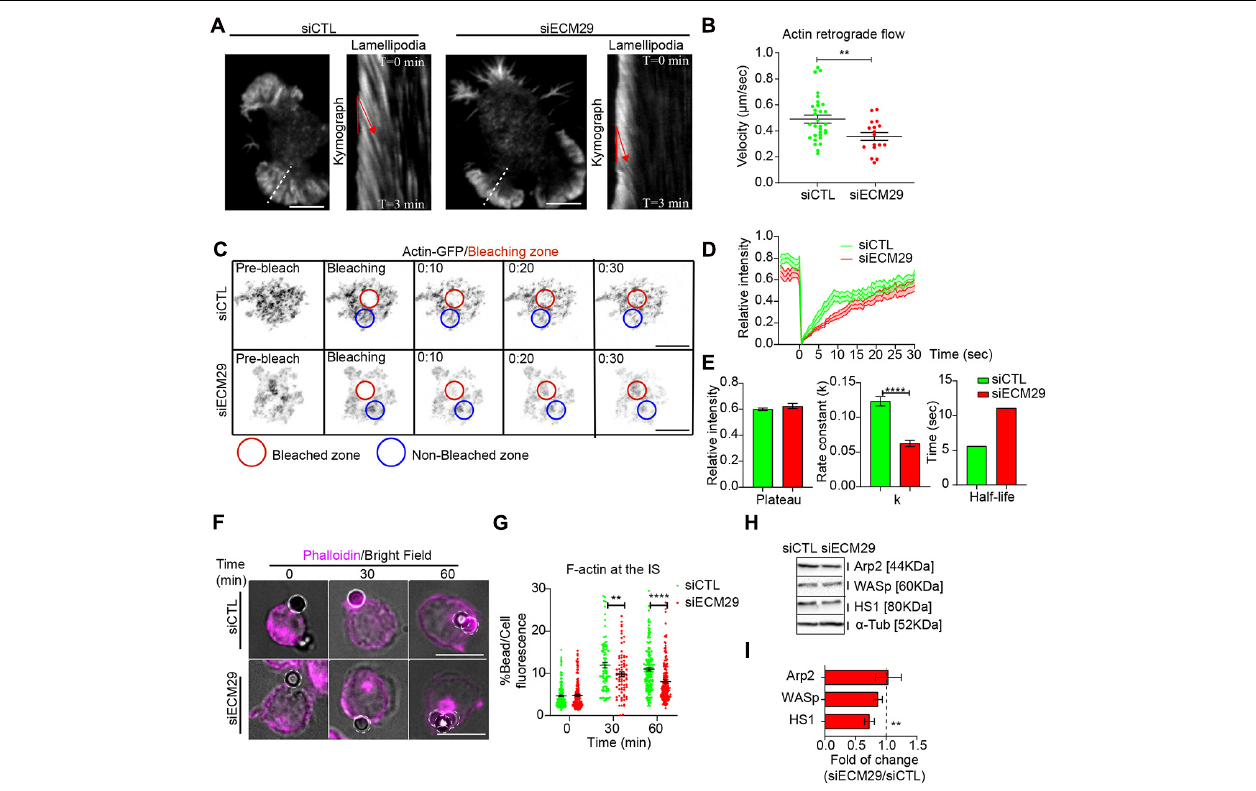
FIGURE 4 | Ecm29 silencing reduces actin dynamics and accumulation at the IS: (A) Representative TIRFM images of control (siCTL) and Ecm29-silenced (siECM29) B cells after 30 min of activation and their respective kymographs of lamellipodia (white dashed line). Red lines represent the actin retrograde flow angle. (B) Quantification of actin retrograde flow in (A) . N = 17. (C) Time-lapse FRAP-TIRFM images of control and Ecm29-silenced B cells expressing Actin-GFP (grayscale) after 30 min of activation. Red and blue circles represent the bleached and non-bleached zone, respectively. (D,E) Quantification of Fluorescence Recovery After Photobleaching of Actin-GFP, and associated parameters (plateau, k, and half-life). N = 15. (F) Representative epifluorescence images of control and Ecm29-silenced B cells activated with antigen-coated beads for different time points, labeled for F-actin (Phalloidin) are shown. (G) Quantification of F-actin accumulation at the bead in F. N > 3. Cells > 80. (H) Representative immunoblot of control and Ecm29-silenced B cells. Arp2, WASp, HS1, and α -Tub are shown. (I) Quantification of protein levels in (E) . N > 4. ** p < 0.01. **** p < 0.0001. A Mann–Whitney was performed. Mean with SEMs and individual experiments (points) (A,G) , and boxes with SEM (I) are shown. Scale bar = 10 µ